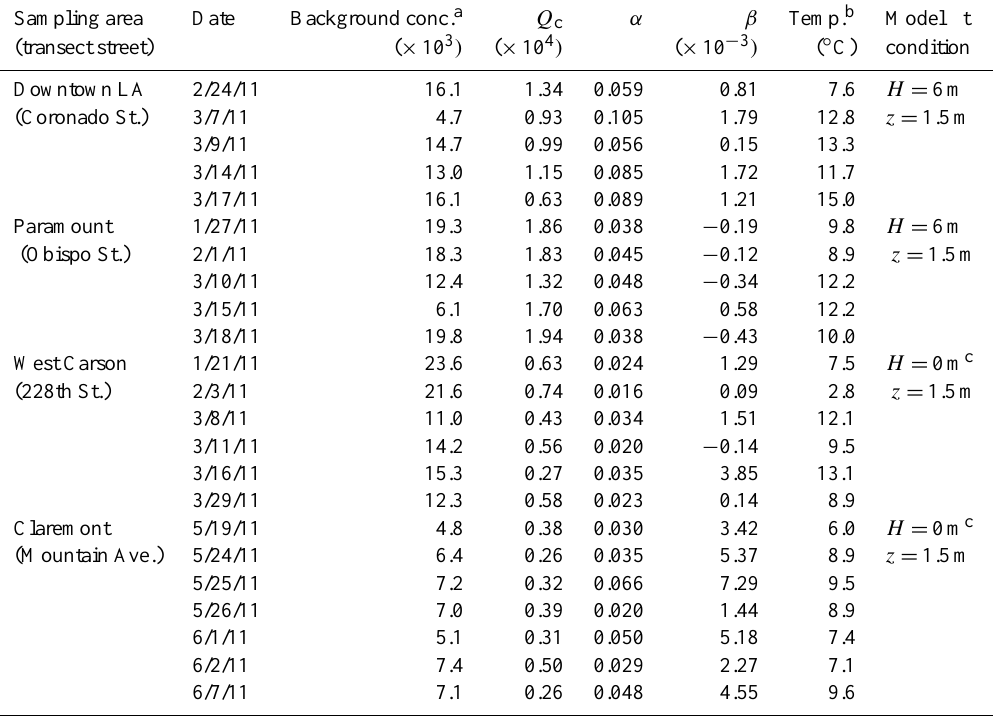
Table 2. Summary of measurements, estimated emission parameters, Q c , and dispersion coefficients ( α and β) from the semi-empirical GB model. All measurements were made within the period 04:30 to 06:30a.m.LT and were completed before the local sunrise